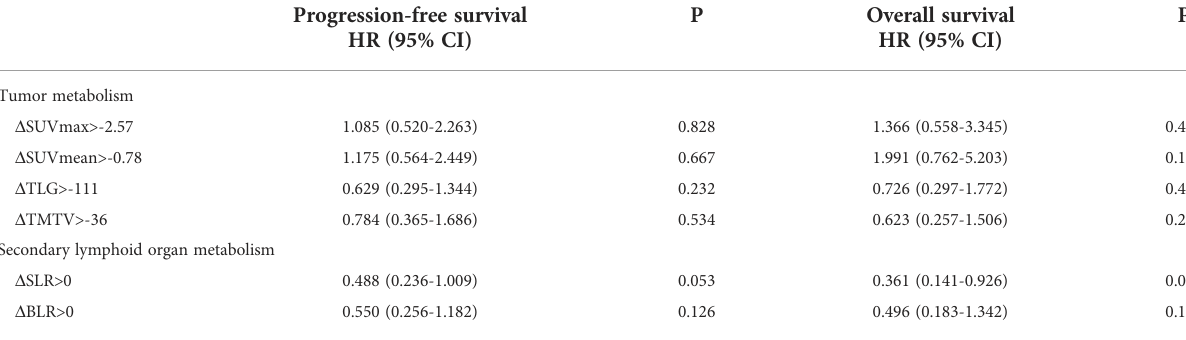
TABLE 4 Univariate analyses of prognostic signi fi cance of D SUVmean, D SUVmax, D TLG, D TMTV, D SLR, and D BLR in progression-free survival and overall survival. Progression-free survival P Overall